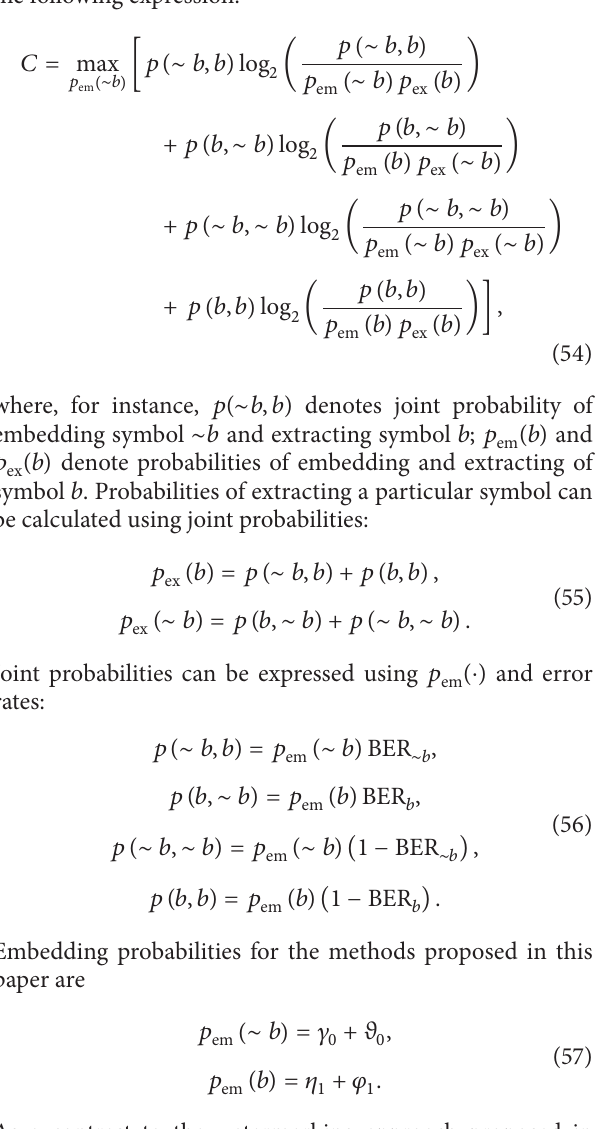
The capacity plots for NS-QIM, NSC-QIM, and RDM in case of JPEG attack are shown in Figure